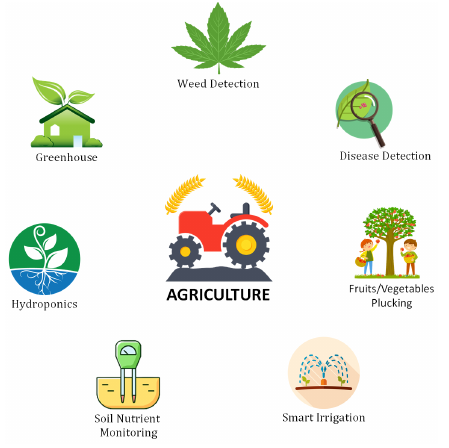
Figure 13. Applications of DL in agriculture. Table 2. State-of-the-art contributions in DL-based